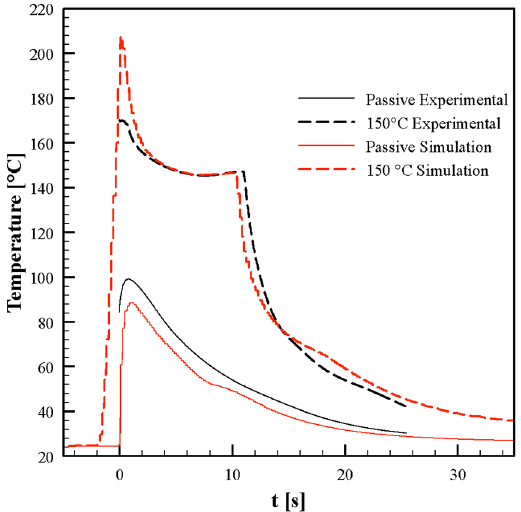
Figure 6. Recorded (black lines) and simulated (red lines) temperature evolutions in position P2